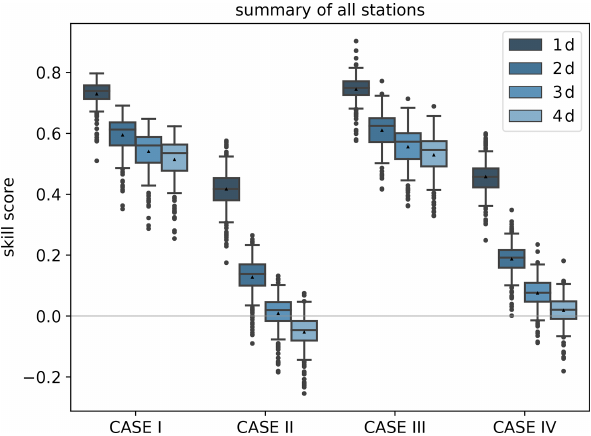
Figure 5. Skill scores of IntelliO3-ts with respect to climatological reference forecasts: with internal single value reference (Case I), internal multi-value (monthly) reference (Case II), external single (Case III), and external multi-value (monthly) reference (Case IV) for all lead times from 1d (dark blue) to 4d (light blue). Triangles denote the arithmetic